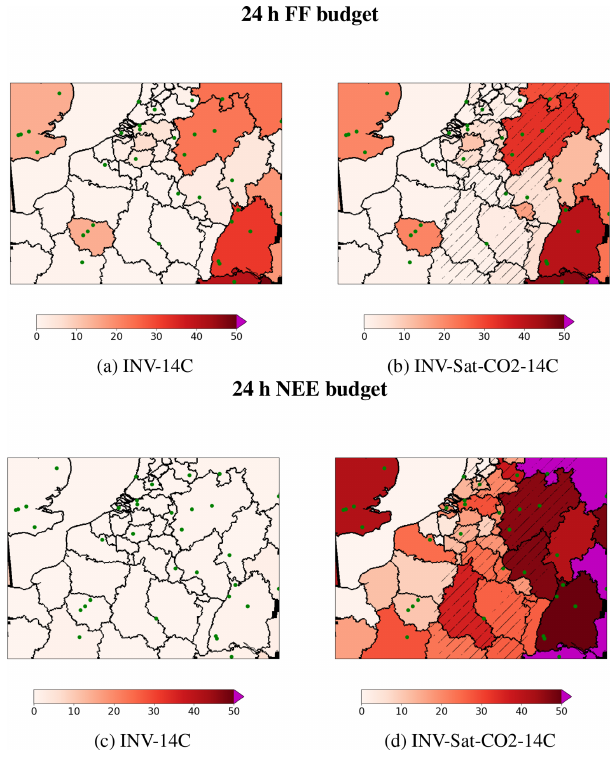
Figure 14. Uncertainty reduction in INV-14C (a, c) and INV-Sat- CO2-14C (b, d) inversions: for 24h budgets of FF emissions (a, b) and biogenic fluxes (NEE, c, d ). Stripes are indicative of the satellite field of view (see Fig. 6 for the full track). Green dots indicate the ground